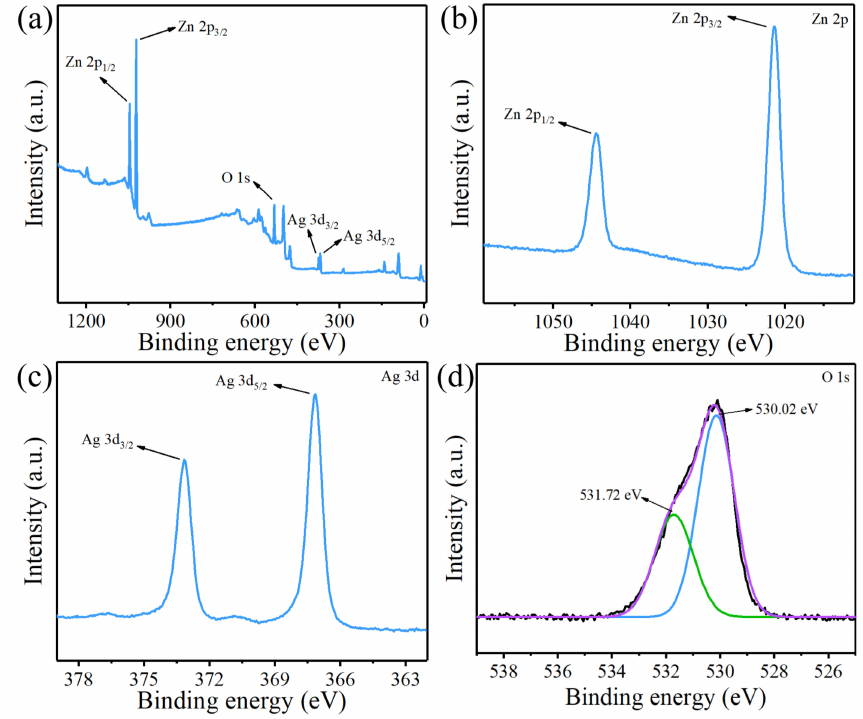
Figure 5. ( a ) XPS of ZnO/Ag2. ( b – d ) High-resolution XPS spectra of Zn 2p, Ag 3d, and O